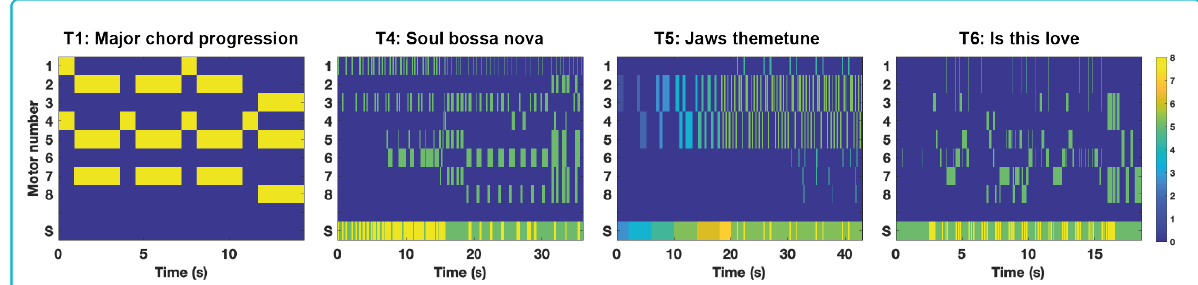
Figure 5. The Pump-and-Vibe tactile stimuli generated for Experiment 2. Panel ( A ) shows the tactile compositions S1–S8 (composed manually for Pump-and-Vibe); sawtooth variations (S1,S2,S3,S7), stroking motion (S4), pinching motion (S6), pulsing (S8) and random activation (S5). Panel ( B ) shows four of the tactile mappings generated from music samples with major chord progressions (T1), Soul Bossa Nova (T4), Jaws theme (T5) and Is this Love (T6). Intensity is shown by hue, motors 1–8 are the vibration motors along the forearm, S is the squeezer on the upper